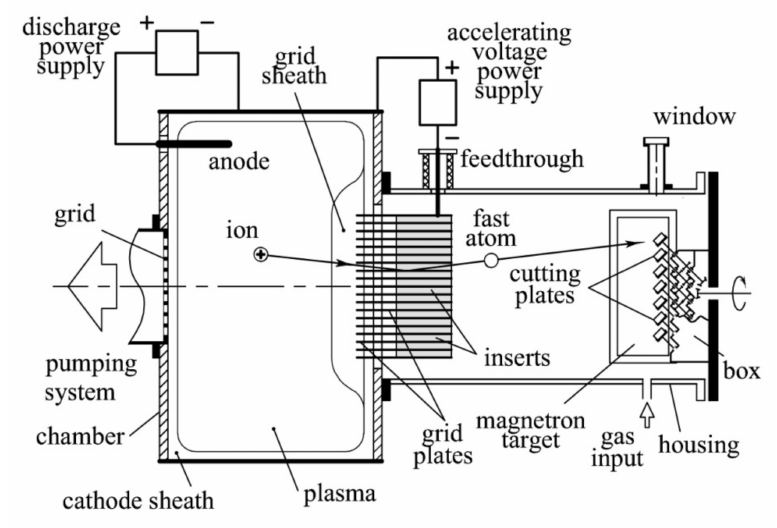
Figure 4. Schematic of the experimental system for processing of dielectric cutting